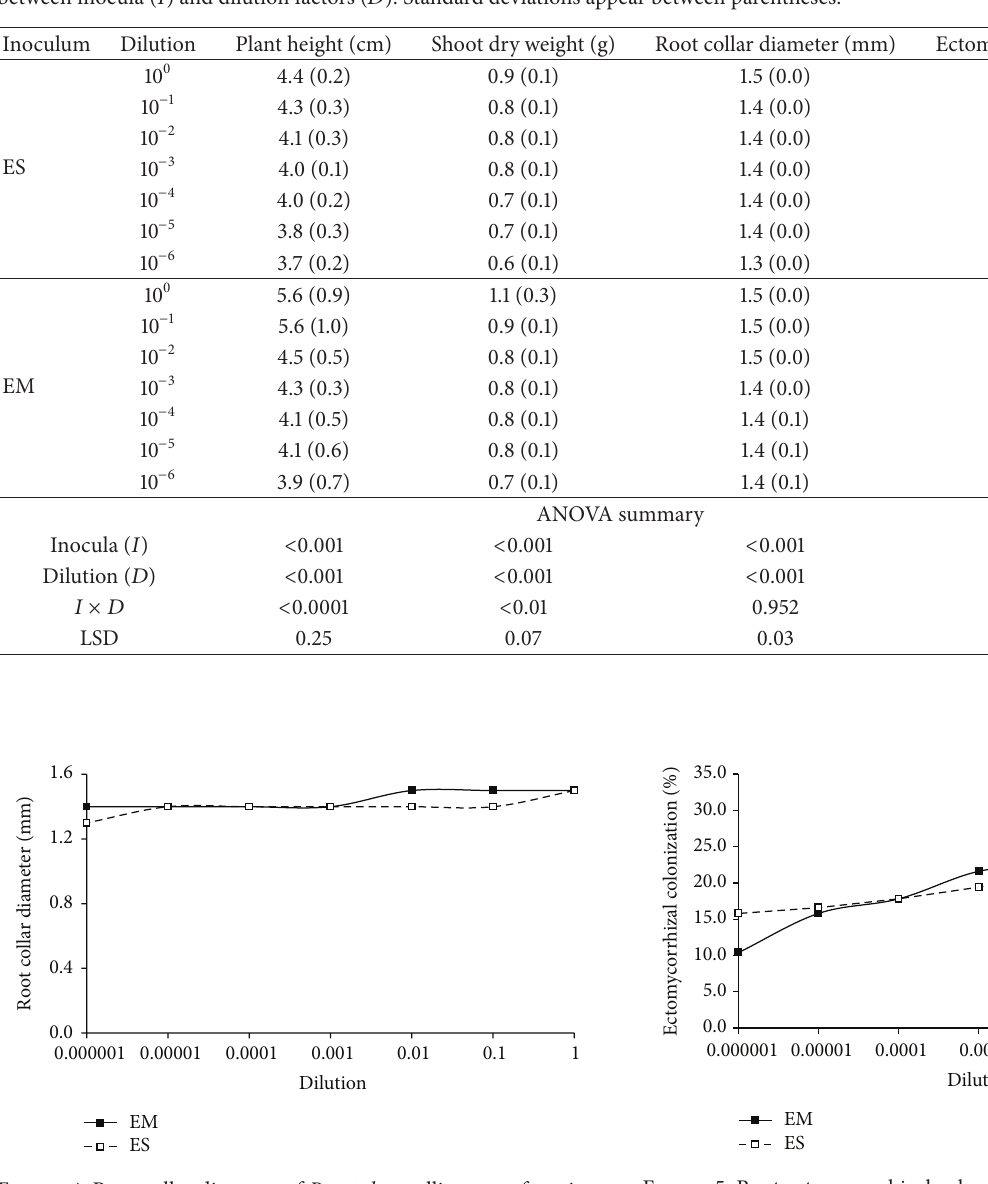
Figure 4: Root collar diameter of P. patula seedlings as a function of EM and ES inoculation at each level of serial dilution.